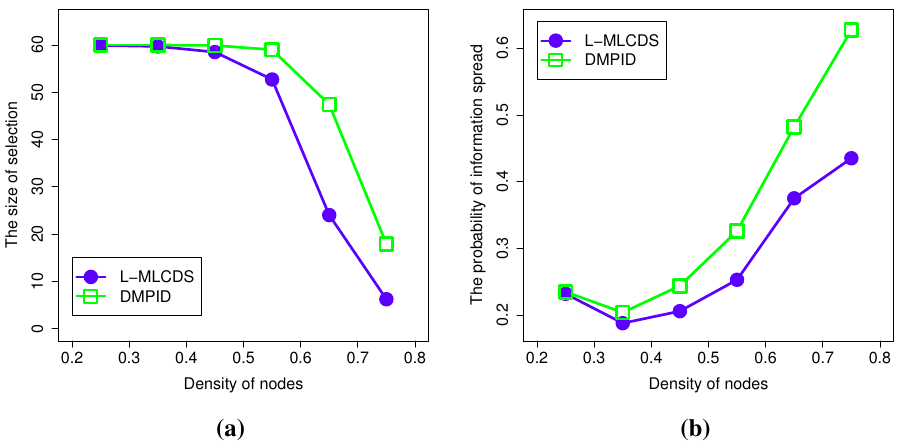
Figure 8. Simulation results for the density of the network. ( a ) The size of the selection; ( b ) The information spread